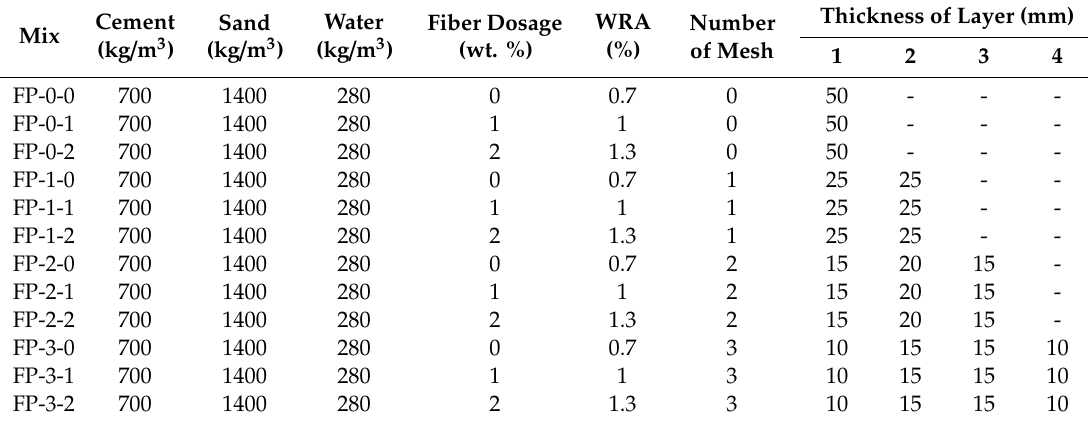
Table 1. Details of mixing composition used in the fabrication of ferrocement panel